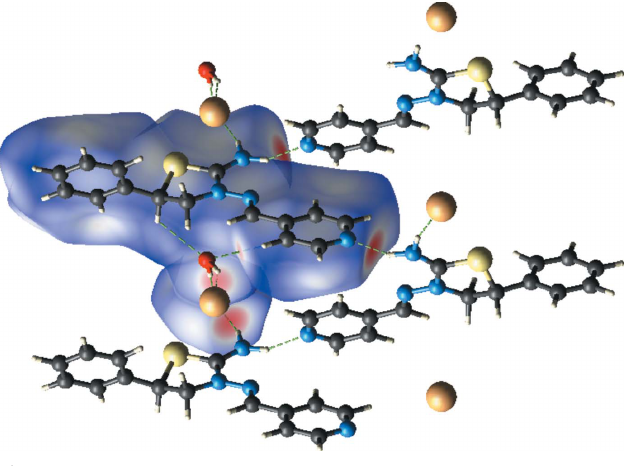
Figure 4 Hirshfeld surface of the title compound mapped over d norm